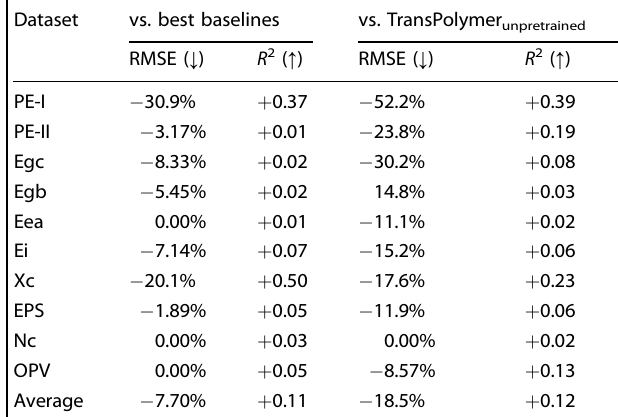
Table 6. Improvement of performance of TransPolymer pretrained compared with baselines and TransPolymer unpretrained in terms of decrease of test RMSE (in percentage) and increase of test R 2 (in absolute